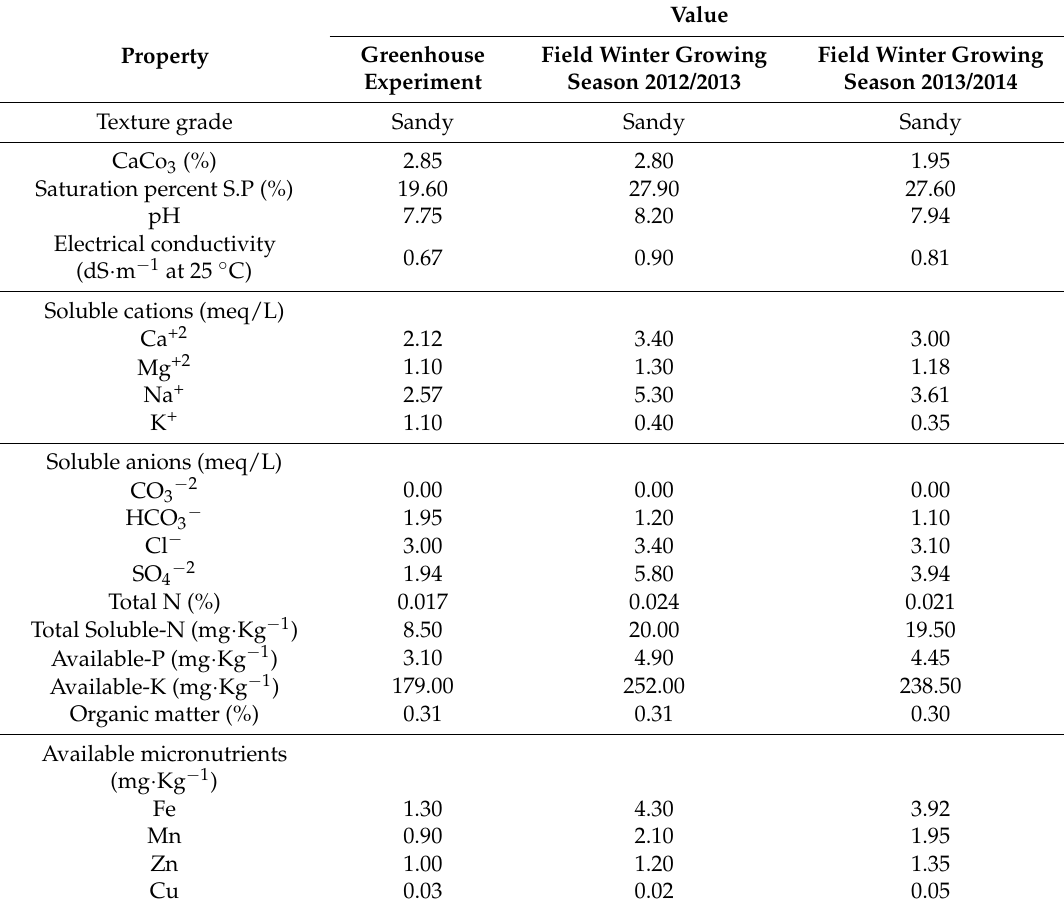
Table 1. Physical and chemical properties of different sandy soils used in this